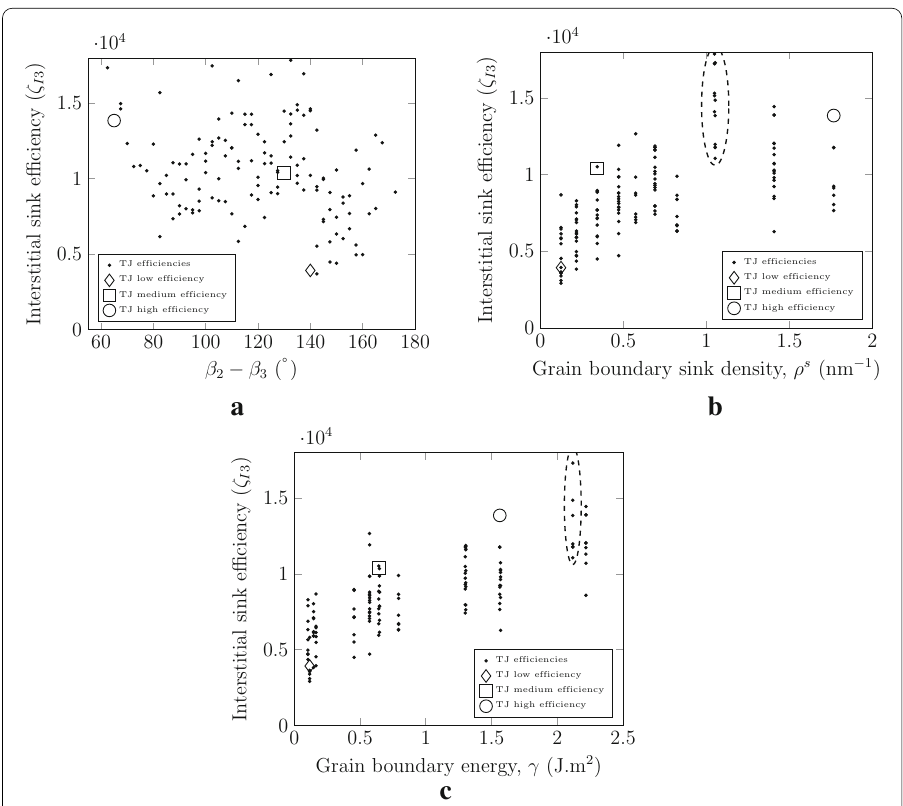
Fig. 5 Interstitial sink efficiency versus a the difference between the largest and smallest dihedral angles of the TJ, b GB sink density (for GB “31”), and c GB energy. Open symbols correspond to TJ regions with low, medium and high sink efficiencies. The dashed elliptical region corresponds to TJs with the highest sink efficiency